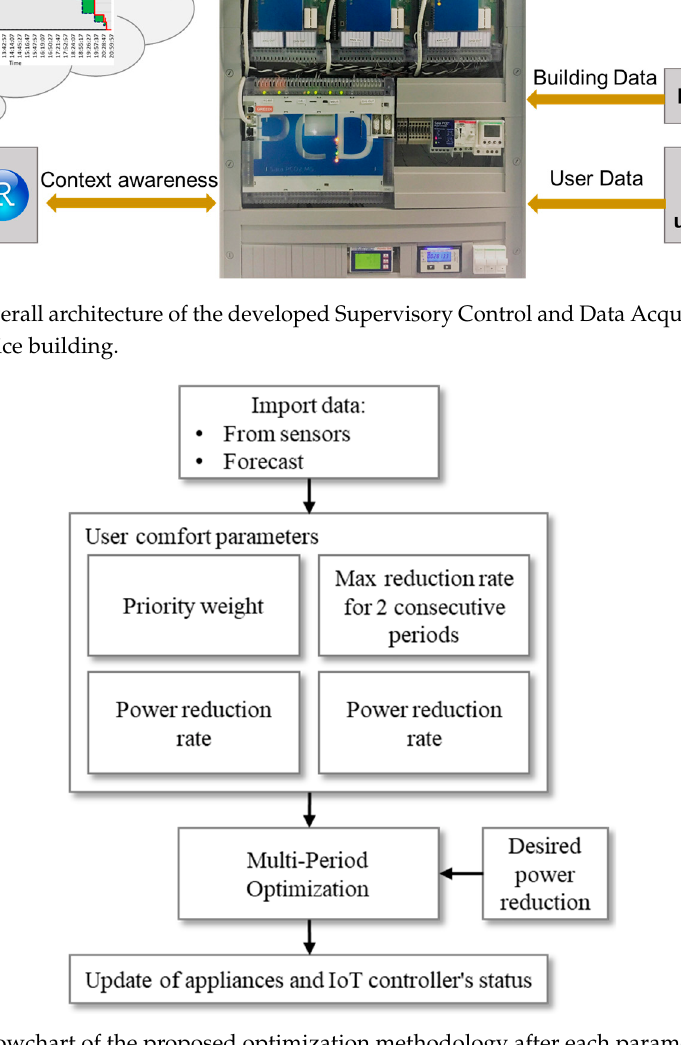
Figure 2. Flowchart of the proposed optimization methodology after each parameter update.